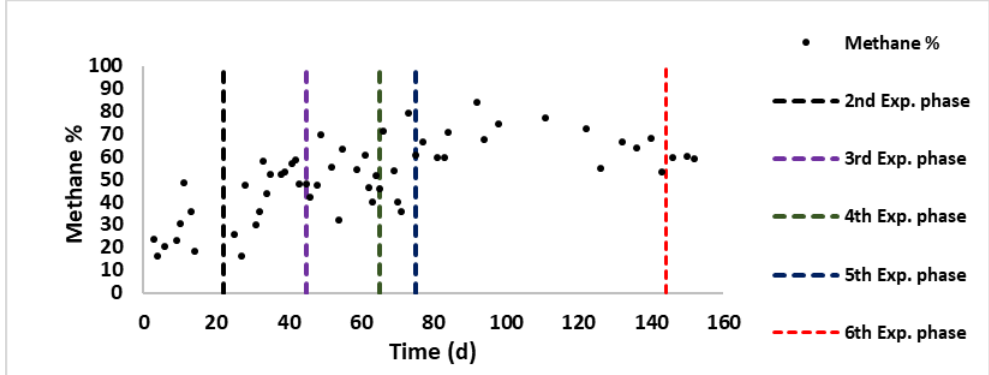
Figure 3 . Daily methane concentration of the biogas generated in the PABR.